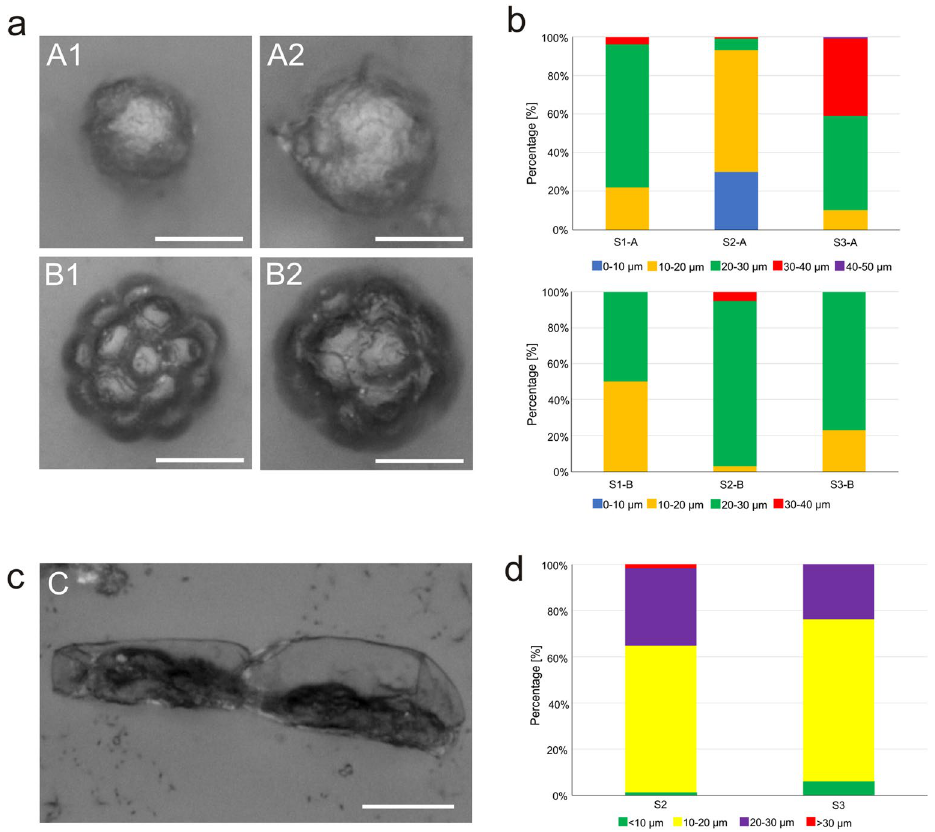
Figure 2. (a) EDF images of fixed S. nivaloides : smooth cysts (A1, A2) and rosette hypnozygotes (B1, B2); (b) cell size class abundances: cysts (top panel) and hypnozygotes (bottom panel) from three sites in Svalbard: S1, S2, S3; (c) EDF image of fixed A. nordenskioeldii ; (d) cell size classes of A. nordenskioeldii from S2 and S3. Scale: 10